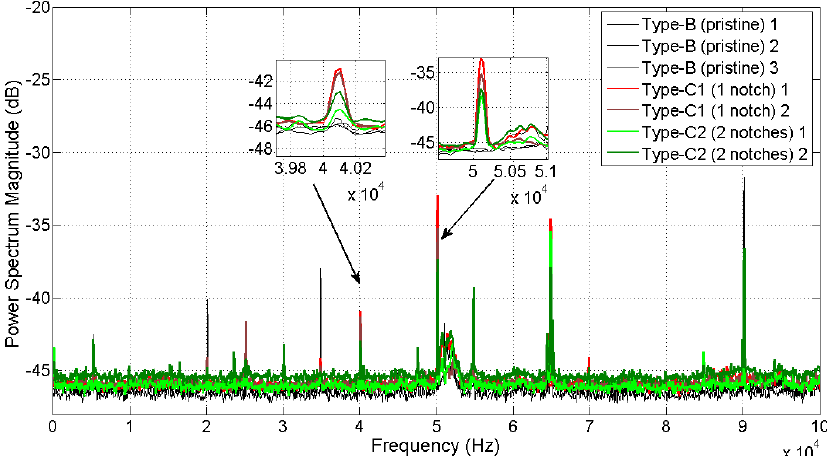
Figure 8. Power spectrum of response of type-C1 and -C2 slabs tested following P2 (type-B shown for comparison): Hidden strip acts as a sensor and damage causes spikes at 40 and 50 KHz (see insets). Table 1. Eigenfrequencies of type-B, -C1 and -C2 slabs as determined by the solution of the finite elements model compared with the ones picked up in signal power spectra.